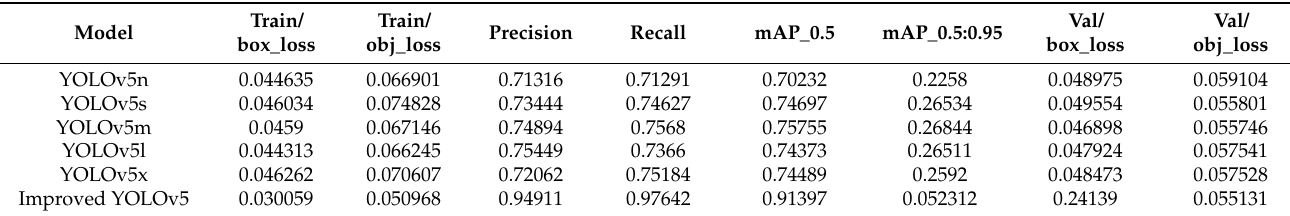
Table 5. Detection results of six YOLOv5 models.